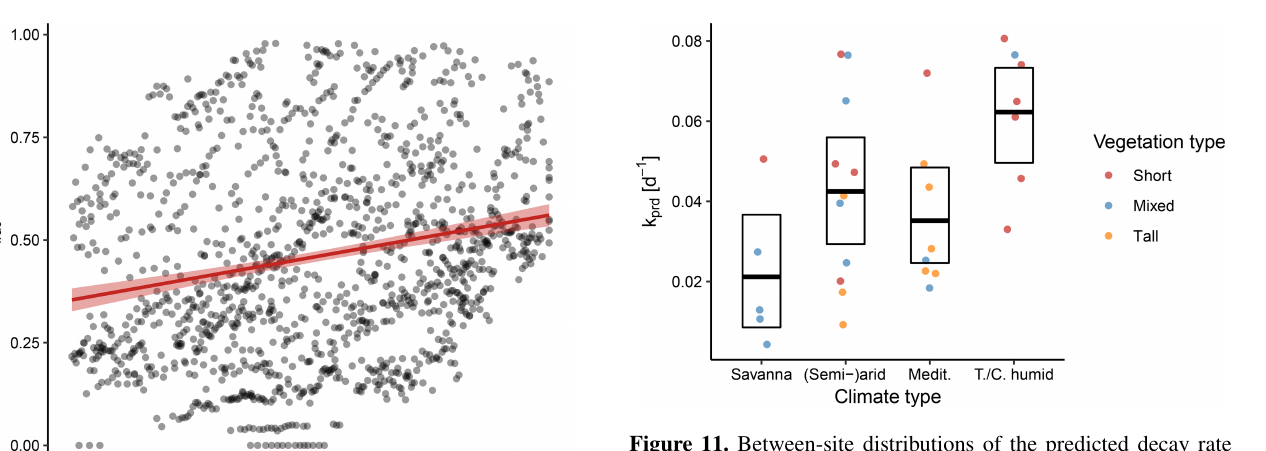
Figure 11. Between-site distributions of the predicted decay rate k stratified according to the aggregated climate and vegetation classes. The points represent individual sites, the bold line denotes the mean across sites, and the box represents the bootstrapped 95% confidence interval.